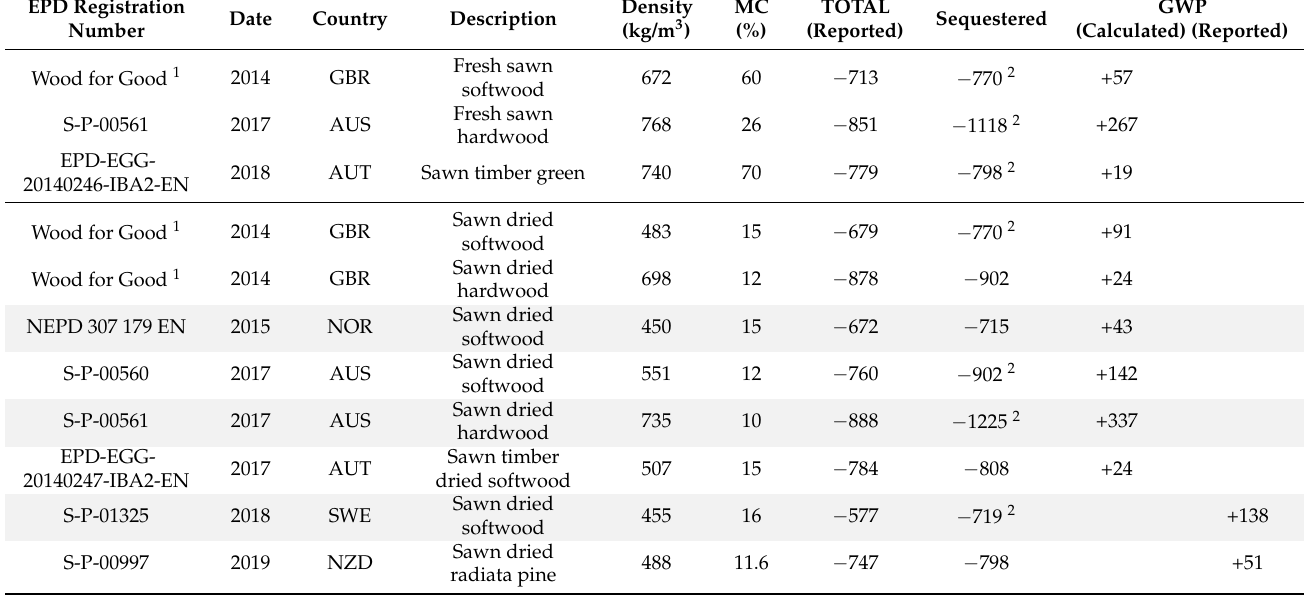
Table 2. Global warming potential (GWP) data for modules A1–A3 (forest to factory gate) (declared unit 1 m 3 ) (GWP in kg CO 2 eq.). Abbreviations: EPD (environmental product declaration), MC (moisture content), EPD (environmental product declaration), TMT (thermally modified